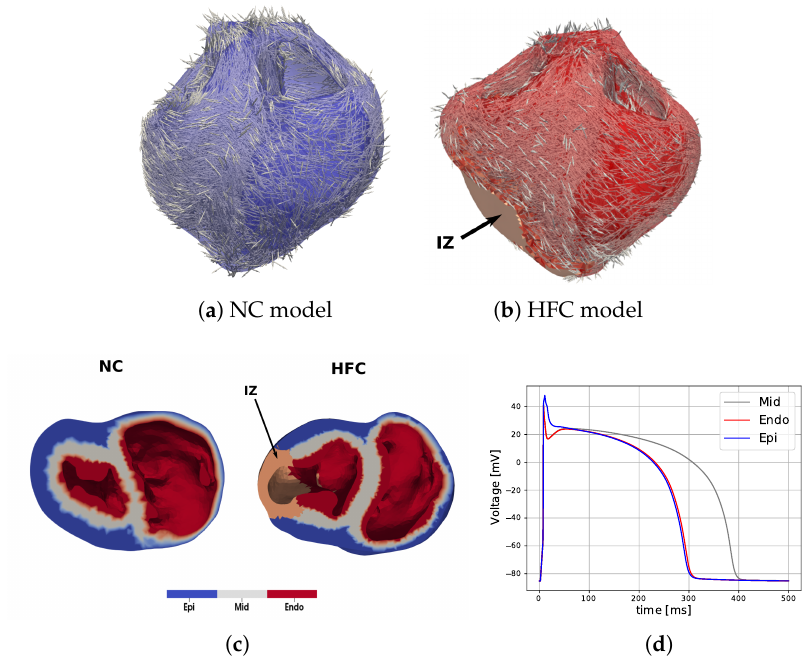
Figure 1. Bi-ventricular heart geometry models and fiber distribution from MRI and DT-MRI datasets. ( a ) Normal (NC) and ( b ) myocardial infarcted (HFC) cases (scar region—infarcted zone—is shown in dark gray). ( c ) Transverse plane section views highlighting the three-layer subdivision adopted for the TP06 model: endocardium (Endo—red), mid-myocardium (Mid—gray), and epicardium (Epi—blue) regions. Infarcted zone (IZ) is shown in orange. ( d ) Time course of the layer-specific action potential parametrization for TP06 ionic